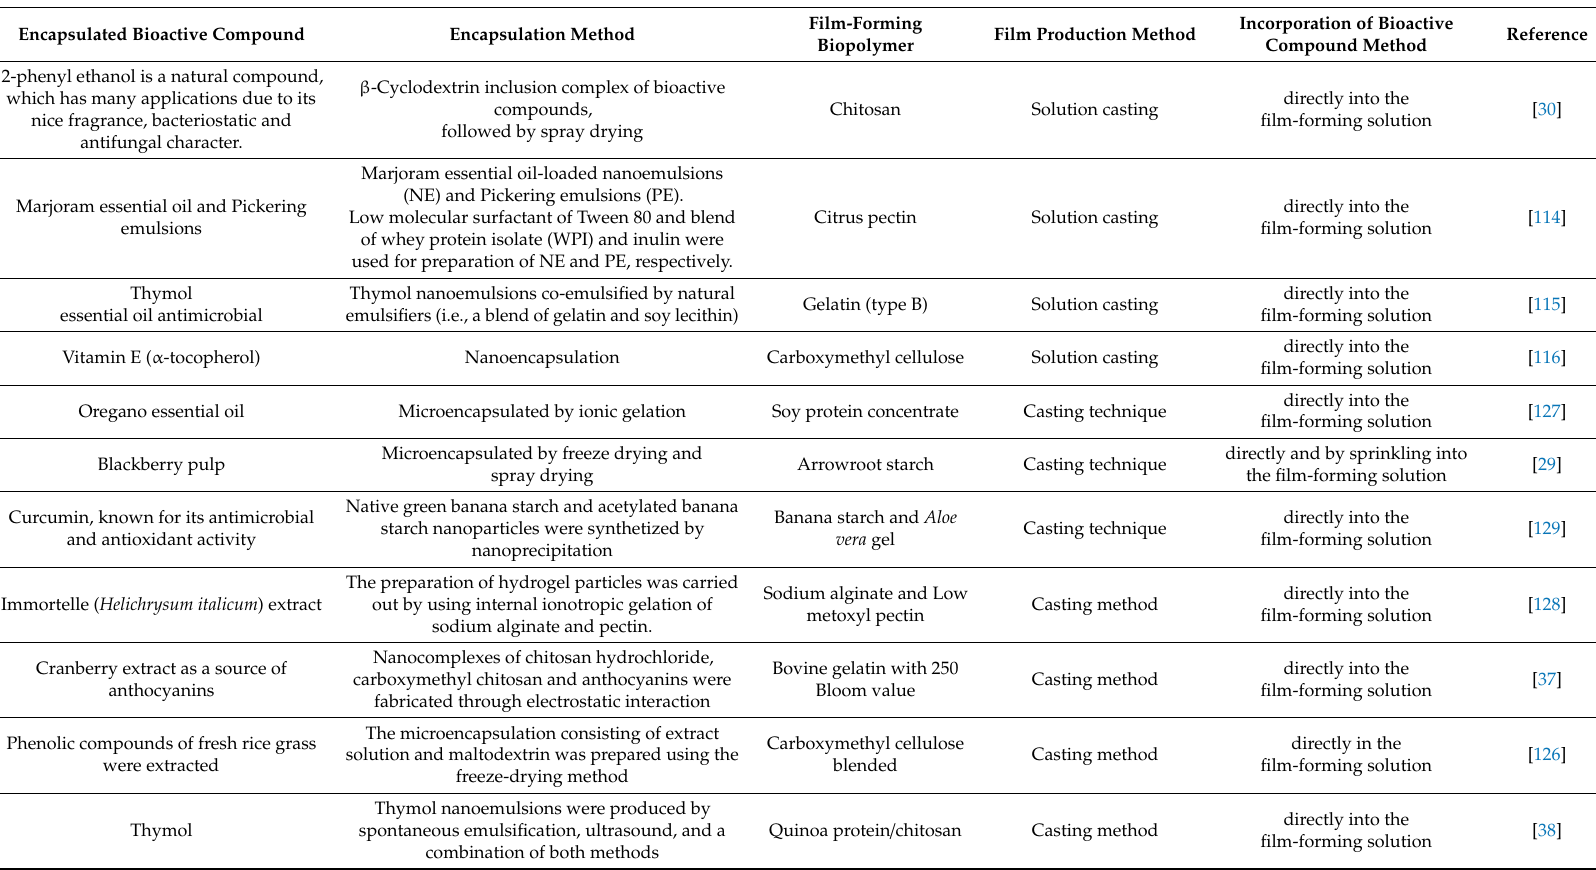
Table 1. Recent examples of films with encapsulated plant-derived bioactive compounds from plant-derived developed by their incorporation into the agro-based polymer during production